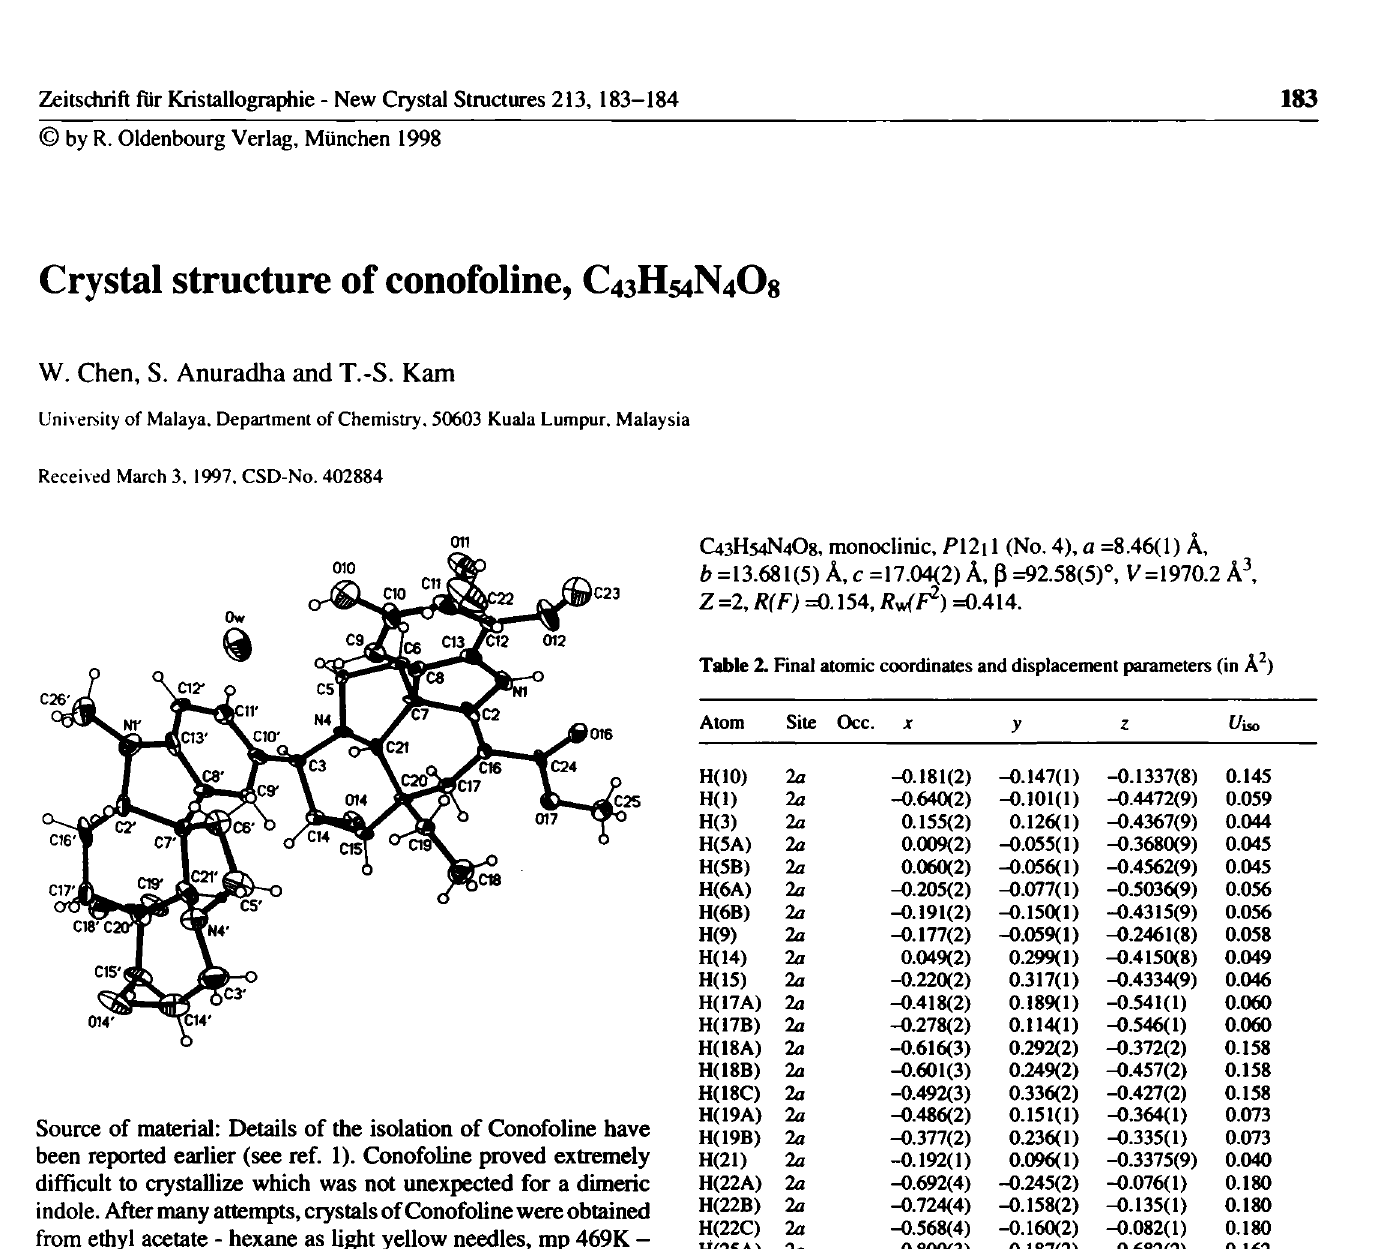
Table 1. Parameters used for the X-ray data collection Crystal: